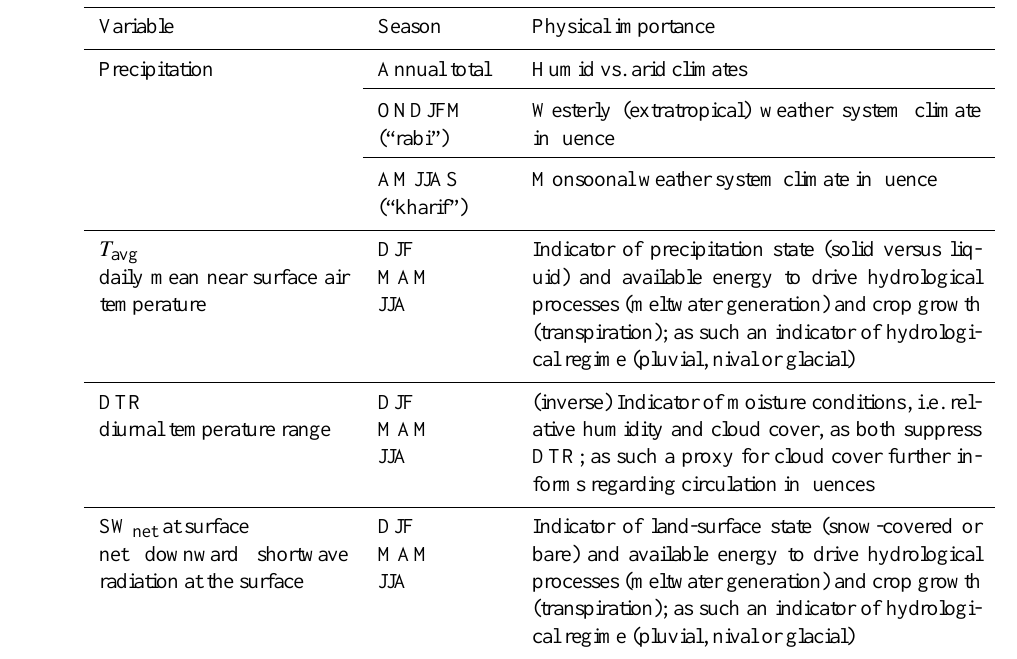
Table 2. Variables used for Himalayan region climate